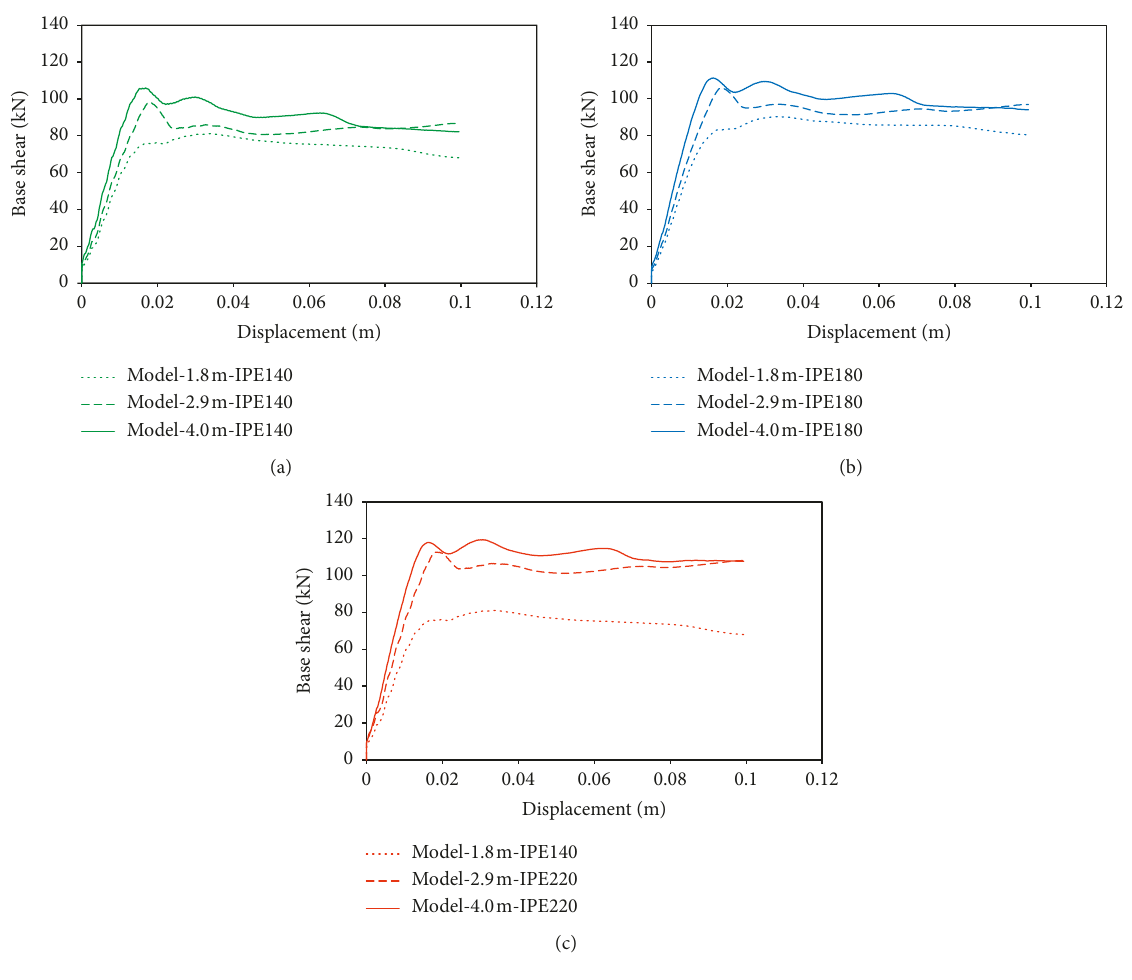
Figure 11: Force-displacement diagrams of the finite element models with (a) IPE140, (b) IPE180, and (c) IPE220.